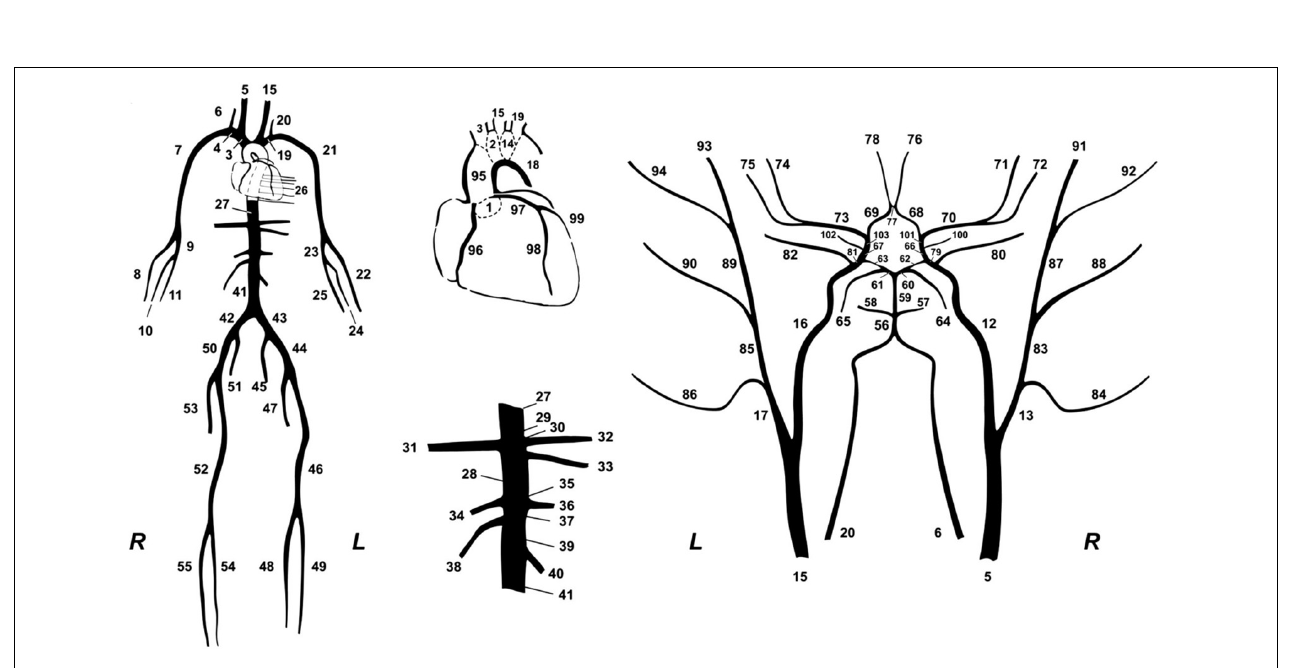
FIGURE 2 | The 1-D cardiovascular model (Reymond et al., 2009) that was used for the data generation.